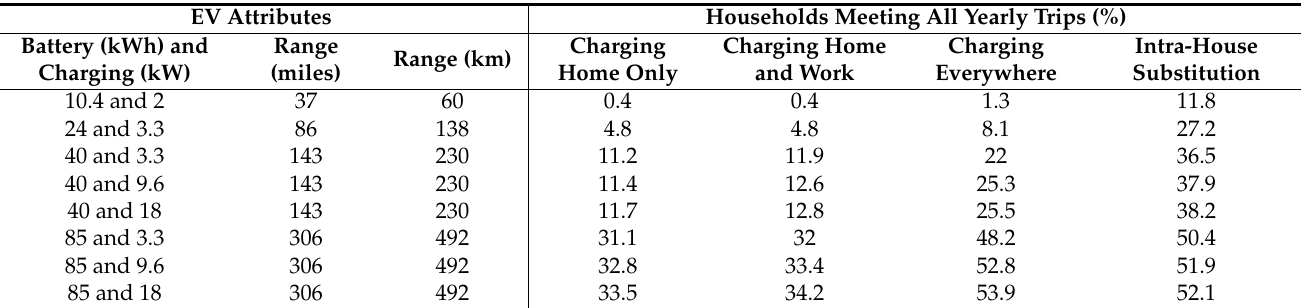
Table 4. Percentage of households that never require adaptations, given the EVs’ attributes (rows) and comparing across charging locations (columns under “Households meeting all yearly